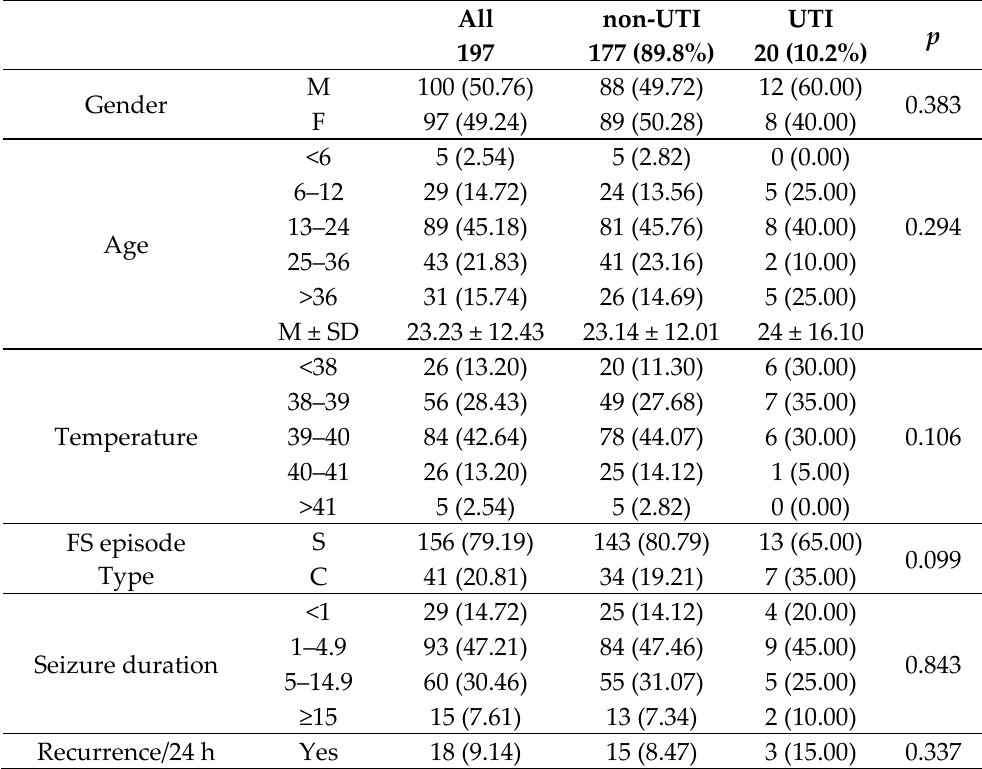
Table 1. Description of the demographic and clinical data.